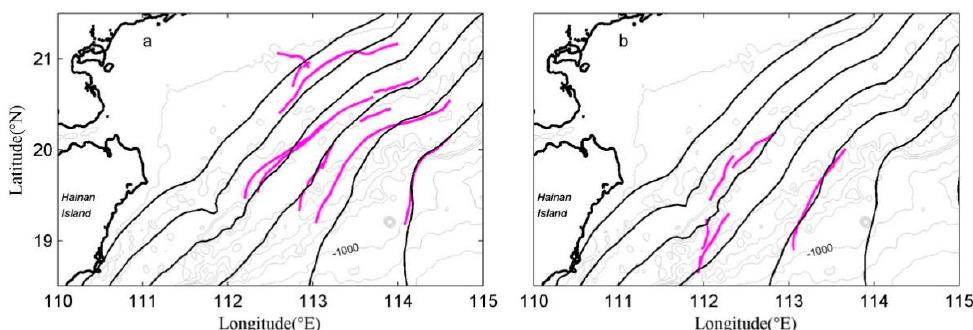
Figure 6. Specific comparisons for simulated and observed wavefronts for the type-S waves ( a ) and type-D waves ( b ). The magenta lines in ( a , b ) are extracted from Figure 2 and Figure 3, respectively. The black lines are drawn every 12 h.